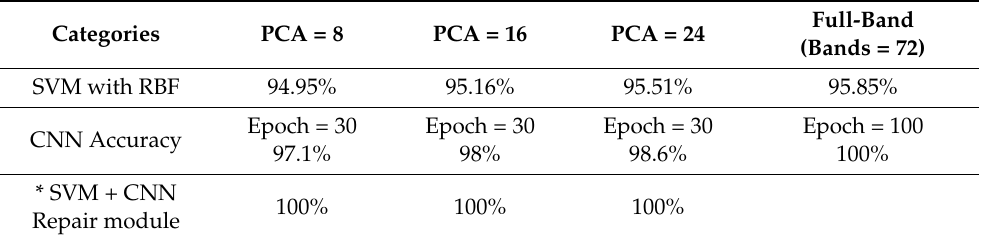
Table 7. The classification outcomes of SVM and SVM + CNN.